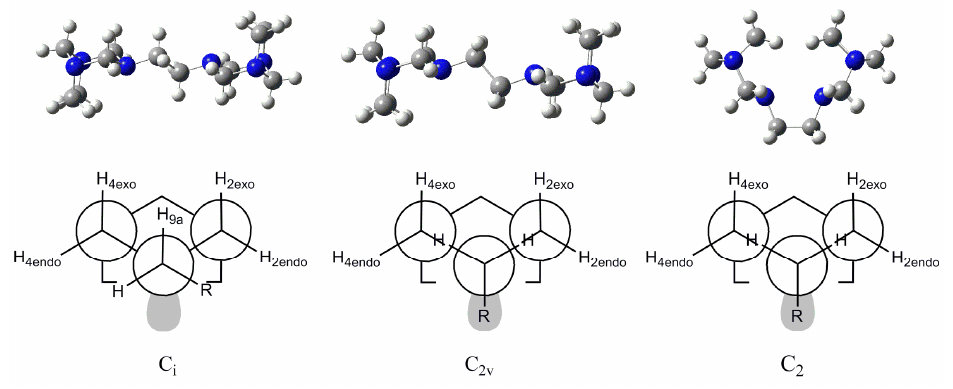
Figure 3. Newman projections of C i , C 2V and C 2 conformations of ETABOC.